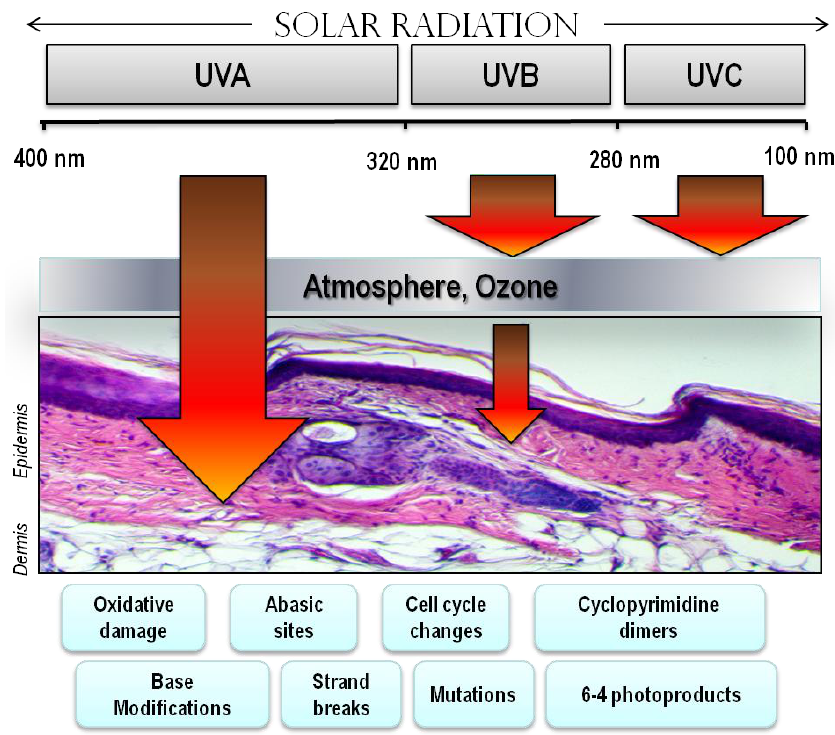
Figure 3. Electromagnetic spectrum of visible and UV radiation and biologic effects on the skin. Solar UV radiation can be subdivided into UVA, UVB and UVC components, however because of atmospheric ozone that absorbs UVC, ambient sunlight is predominantly UVA (90%–95%) and UVB (5%–10%). UV penetrates the skin in a wavelength- dependent manner. Longer wavelength UVA penetrates deeply into the dermis reaching well into the dermis. In contrast, UVB is almost completely absorbed by the epidermis, with comparatively little reaching the dermis. UVA is efficient at generating reactive oxygen species that can damage DNA via indirect photosensitizing reactions. UVB is directly absorbed by DNA which causes molecular rearrangements forming the specific photoproducts such as cyclobutane dimers and 6–4 photoproducts. Mutations and cancer can result from many of these modifications to